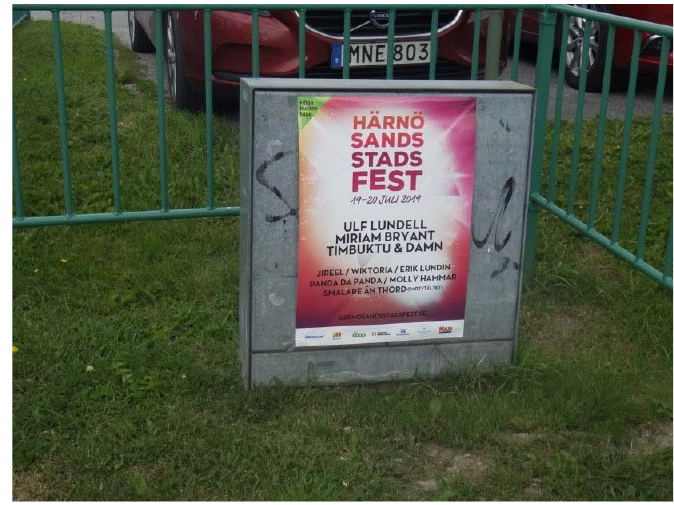
Figure 2. Poster for City Party .